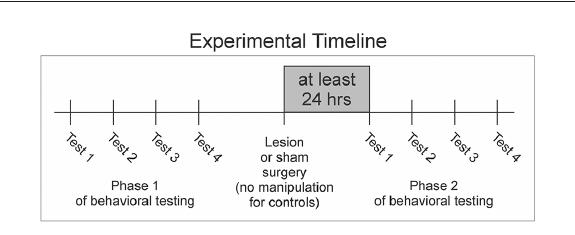
FIGURE1 Females underwent two phases of behavioral testing. In each phase,femalescompletedfourvalidtestsofpreferenceforsongs performedbyeachofsevenmales.AfterthecompletionofPhase 1, experimental and sham birds received either lesion or sham surgeries before moving onto Phase 2. No manipulation was performed on control birds (detailed in “Methods”